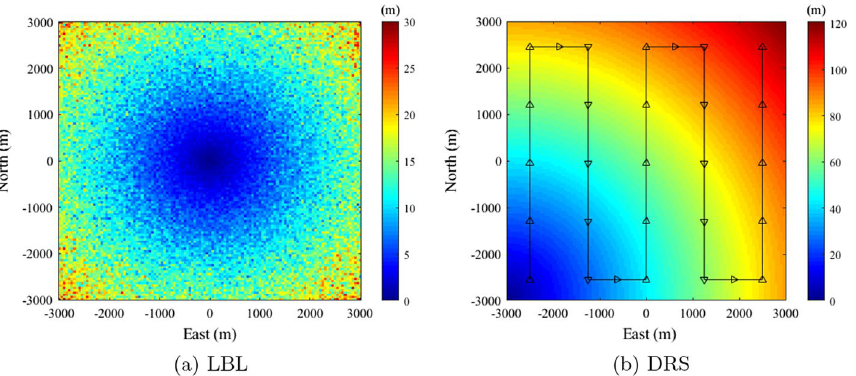
Fig. 6 Comprehensive error results of LBL and DRS